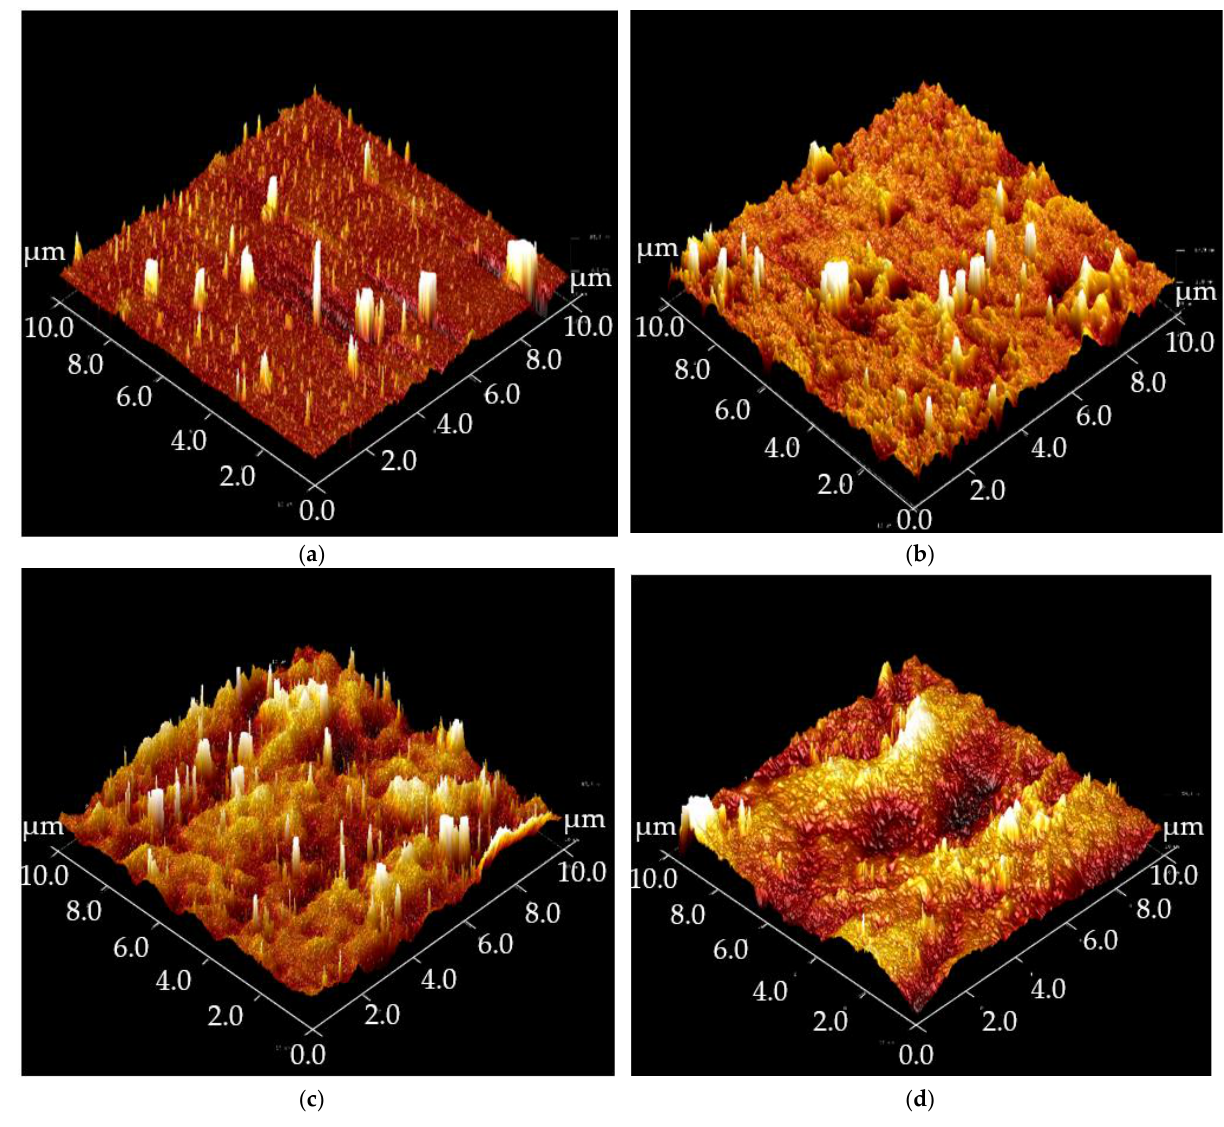
Figure 5. The average roughness in AFM images of ( a ) PU coating without modification (R-0: 4.15 nm), and ( b ) PU coatings modified using silica in ethanol (E/1.0: 13.4 nm), ( c ) THF (T/1.0: 6.11 nm), or ( d ) paint thinner (P/1.0: 15 nm).